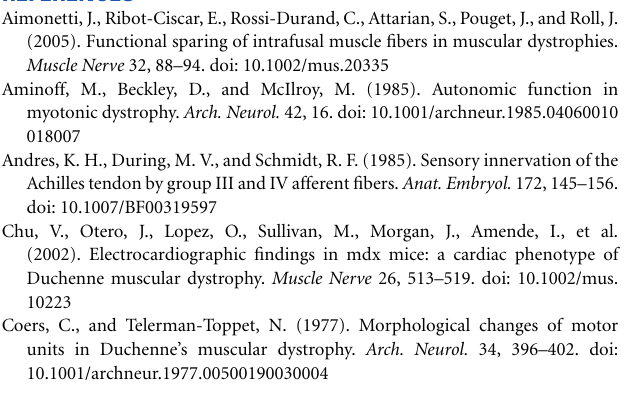
increases in sympathetic nerve activity to the heart, adrenal gland, and vasculature of skeletal muscle, kidneys, and the splanchnic region. Numerous changes that occur with the pathogenesis of muscular dystrophy maintain the potential to both enhance and depress exercise pressor reflex activity. EPR, exercise pressor reflex; MD, muscular dystrophy; PSNA, parasympathetic nerve activity; SNA, sympathetic nerve